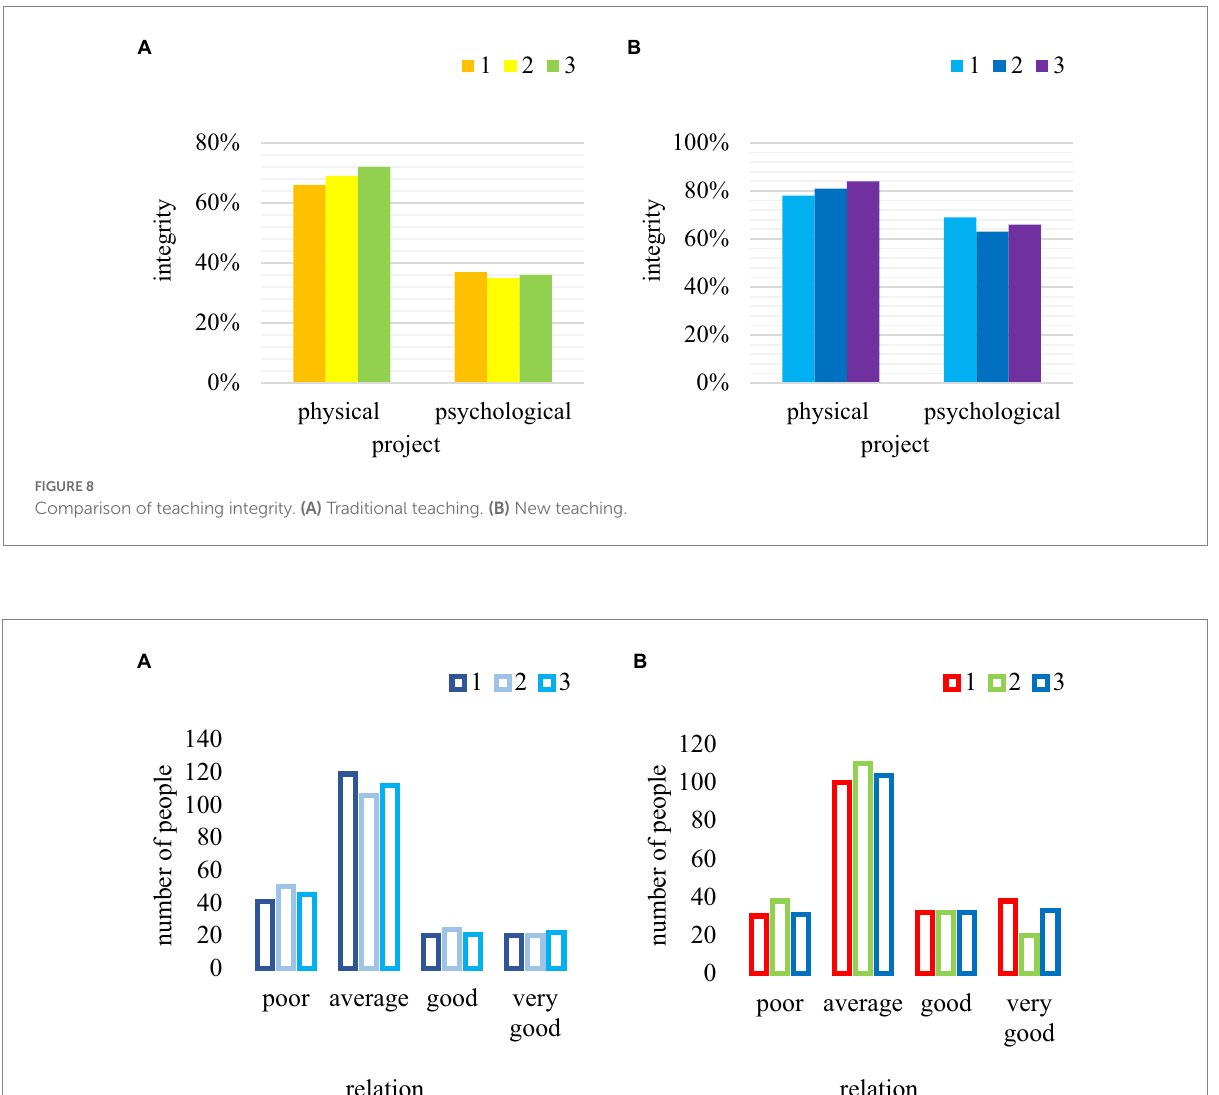
FIGURE 9 Comparison of teacher-student relationship. (A) Traditional teaching. (B) New teaching.